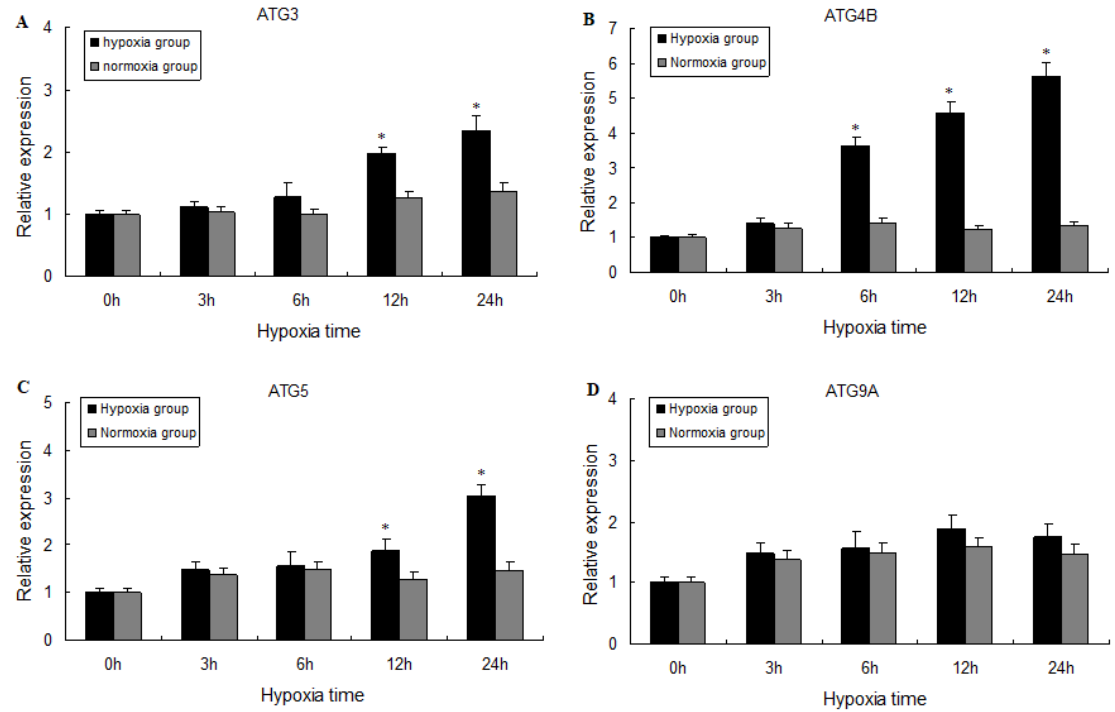
Figure 4. Effects of hypoxia on mRNA expression levels of ATG3 ( A ), ATG4B ( B ), ATG5 ( C ) and ATG9A ( D ) in the brain of M. nipponense . Values are presented as mean ± SEM for triplicate samples. Bars with asterisks indicate significant differences between control and hypoxia groups ( p < 0.05).